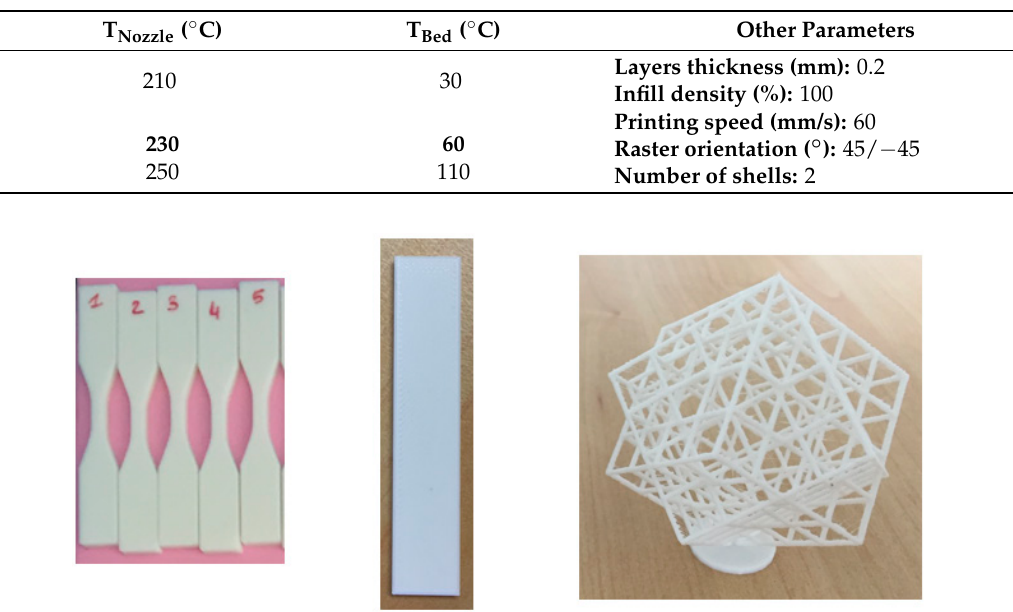
Figure 1. Parts printed from PLA/Hytrel blends (from left to right: tensile samples, impact test sample, 3D printable architectural parts).